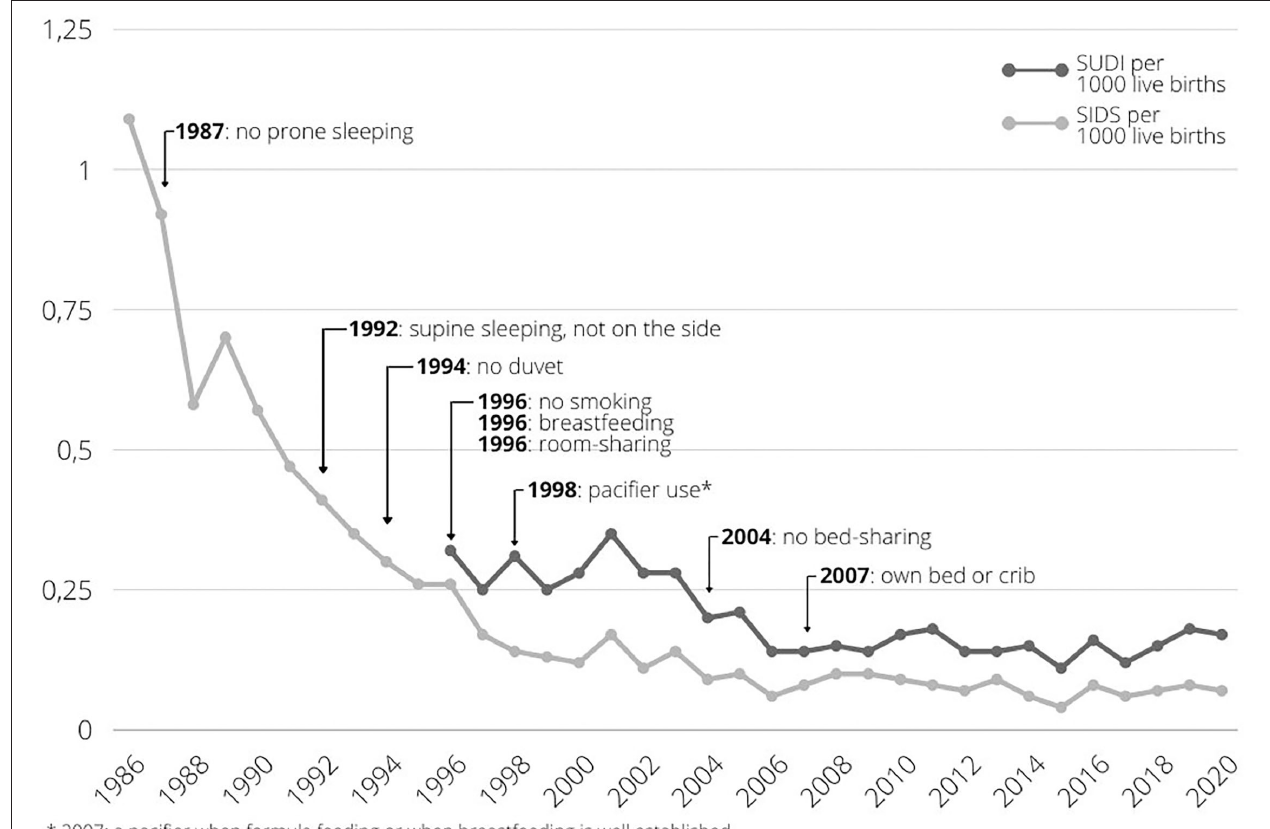
FIGURE 1 | SUDI and SIDS incidence in the Netherlands from 1986 to 2019, with addition of prevention advice elements over time. Data retrieved from Central Bureau for Statistics Netherlands (4). SIDS incidence represents cases coded as R95 in the International Statistical Classification of Diseases and Related Health Problems, 10th Revision (ICD-10). SUDI incidence represents cases coded as R95, and R96: other sudden death, cause unknown, R98 unattended death, R99: other ill-defined and unspecified causes of mortality, W75: accidental suffocation and strangulation in bed, W78: inhalation of gastric contents, W79: inhalation and ingestion of food, causing obstruction of respiratory tract in the ICD-10, as suggested by Taylor et al.